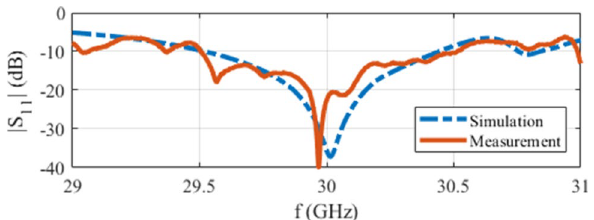
Figure 13. The simulated and measured |S 11 | of the final assembled